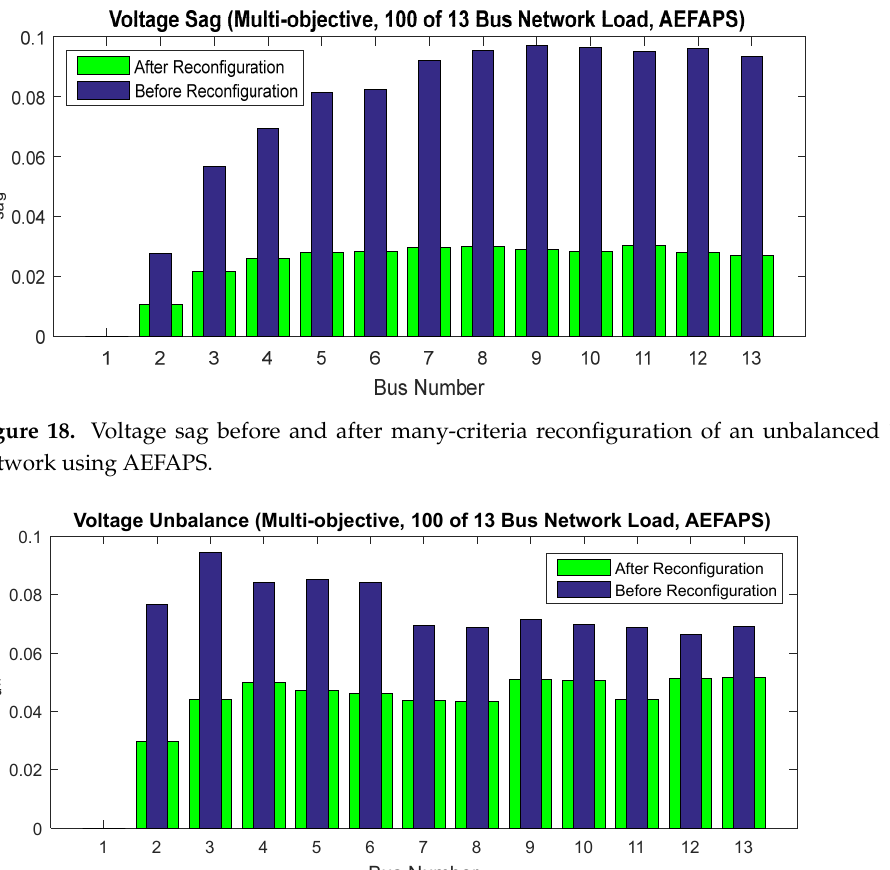
Table 9. The results of many-criteria reconfiguration of an unbalanced 13-bus network (125% of network load).